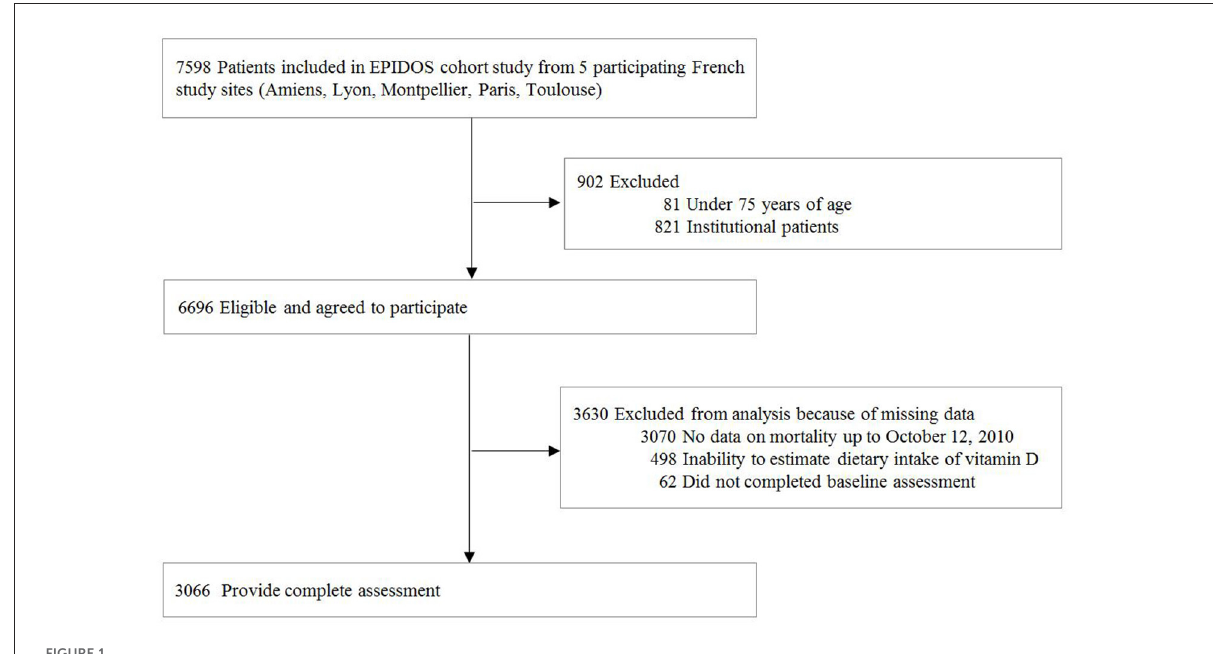
FIGURE1 Participants